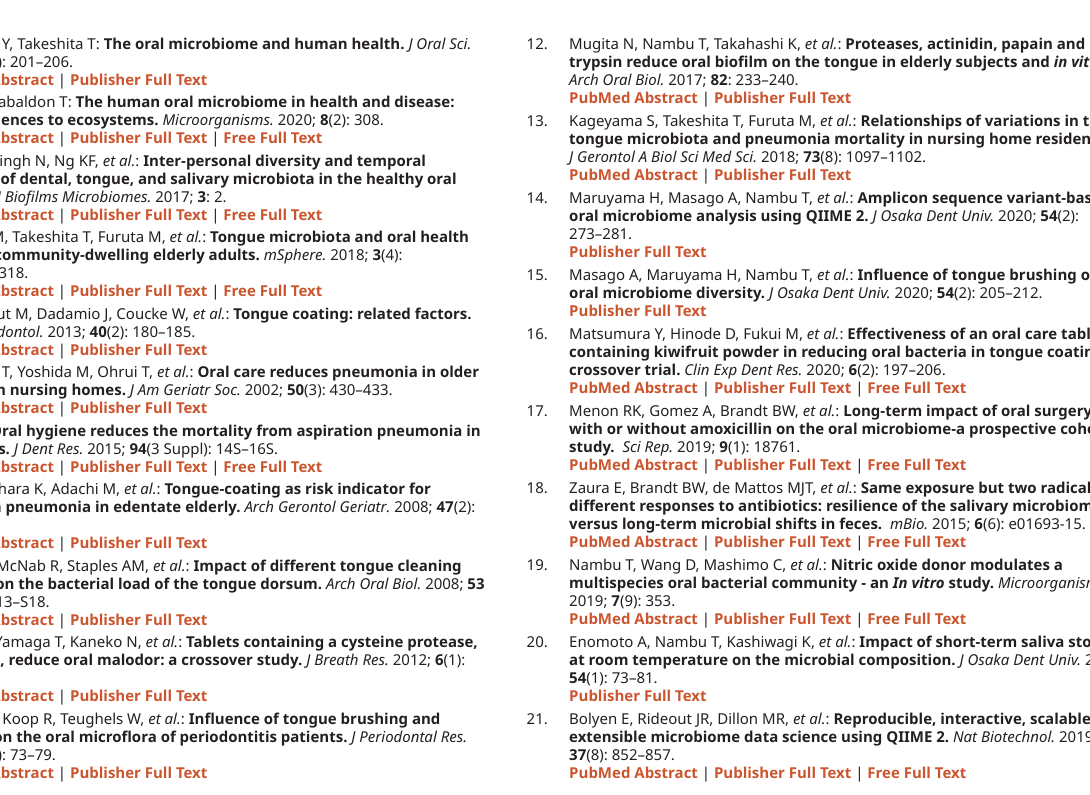
Figshare: Table_S2_clustered-OTU-table.tsv for “Inter-site and interpersonal diversity of salivary and tongue microbiomes, and the effect of oral care tablets”. https://doi.org/10.6084/ m9.figshare.13291535.v1 38 Table_S2_clustered-OTU-table. After open-reference clustering, OTU table was constructed from the BIOM file using QIIME 2. Number of reads for each OTU in each sample are indi- cated, together with the bacterial taxonomy assigned to each OTU. OTU IDs are identical to matching HOMD Refseq IDs, except for those which did not match the